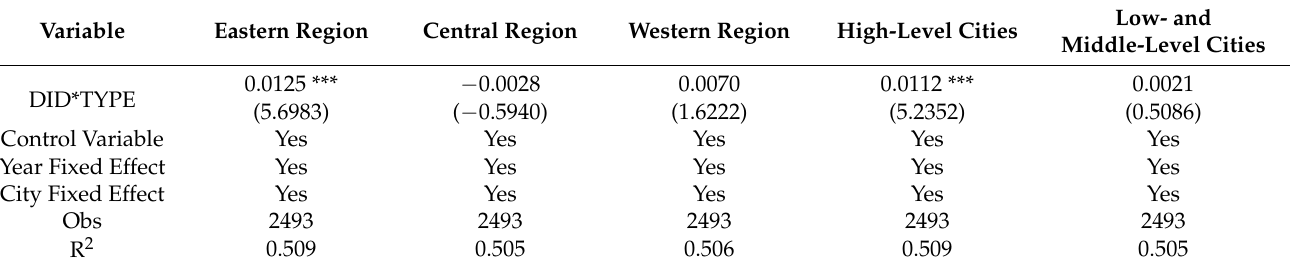
Table 7. Estimated results of urban location and urban administrative level